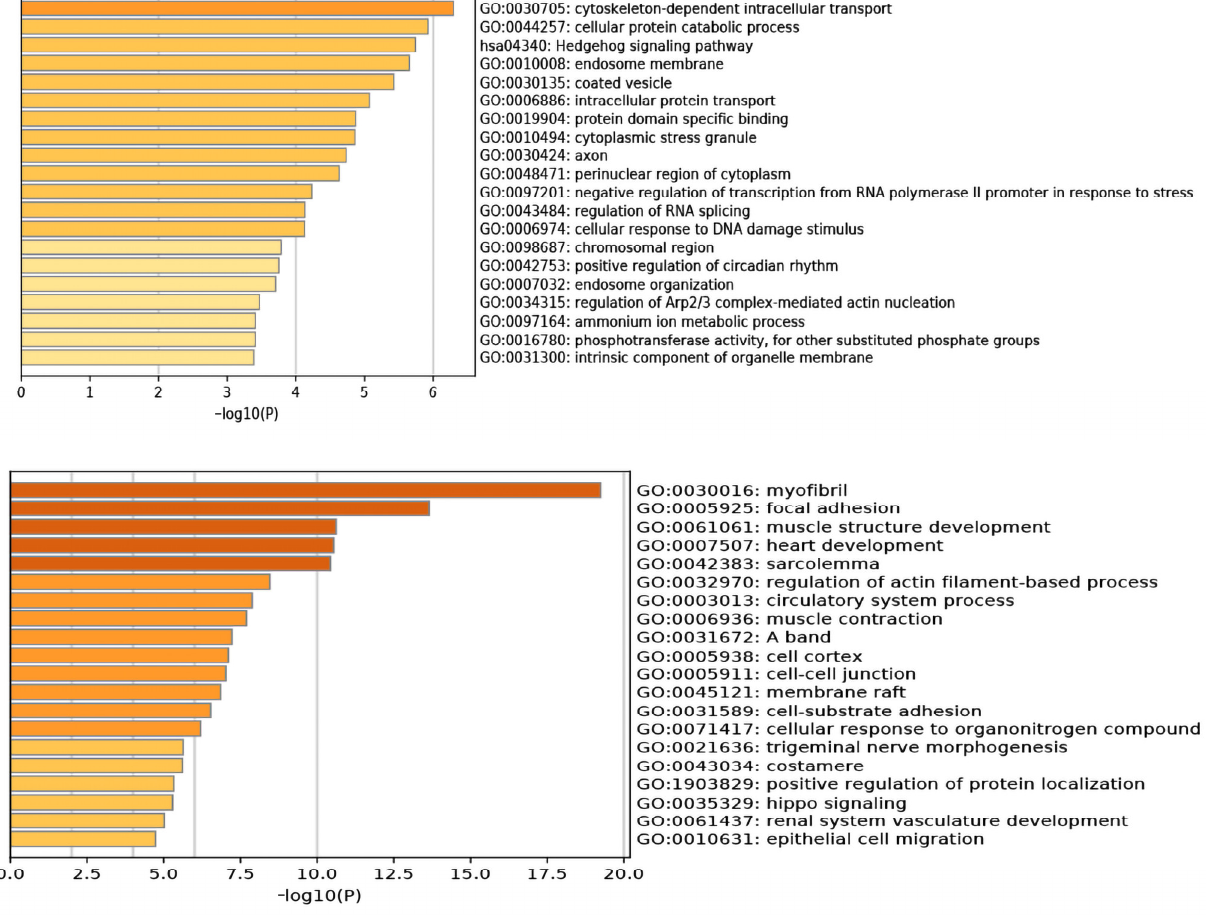
Figure 10. Functional enrichment analysis (including GO and KEGG) of PRLR ( A ) and CACNA2D1 ( B ) associated genes in BRCA.